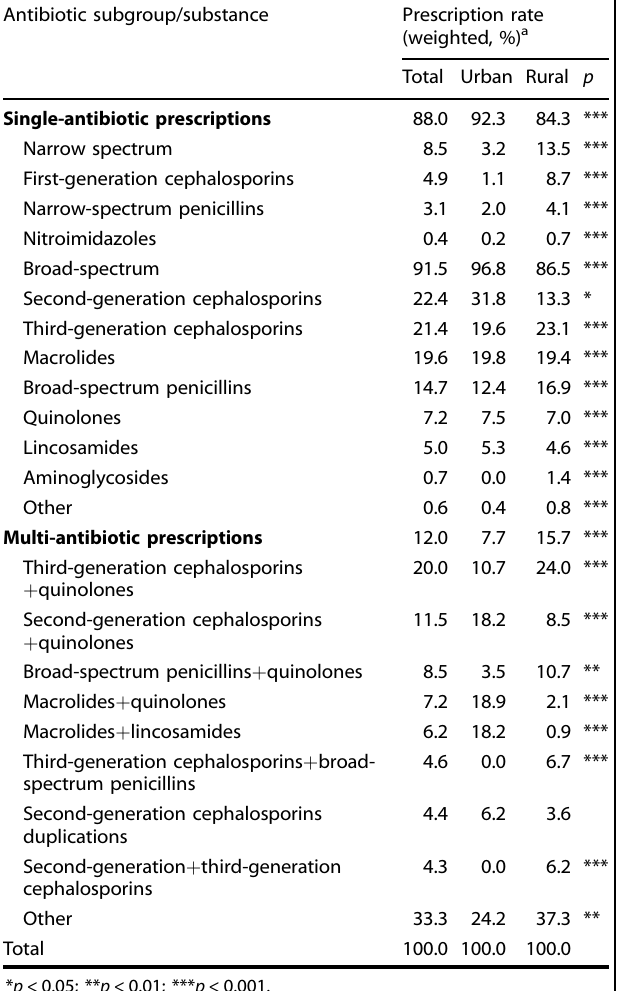
Table 2. Antibiotics prescribed for acute bronchitis at primary healthcare facilities in China, by urban – rural location and antibiotic